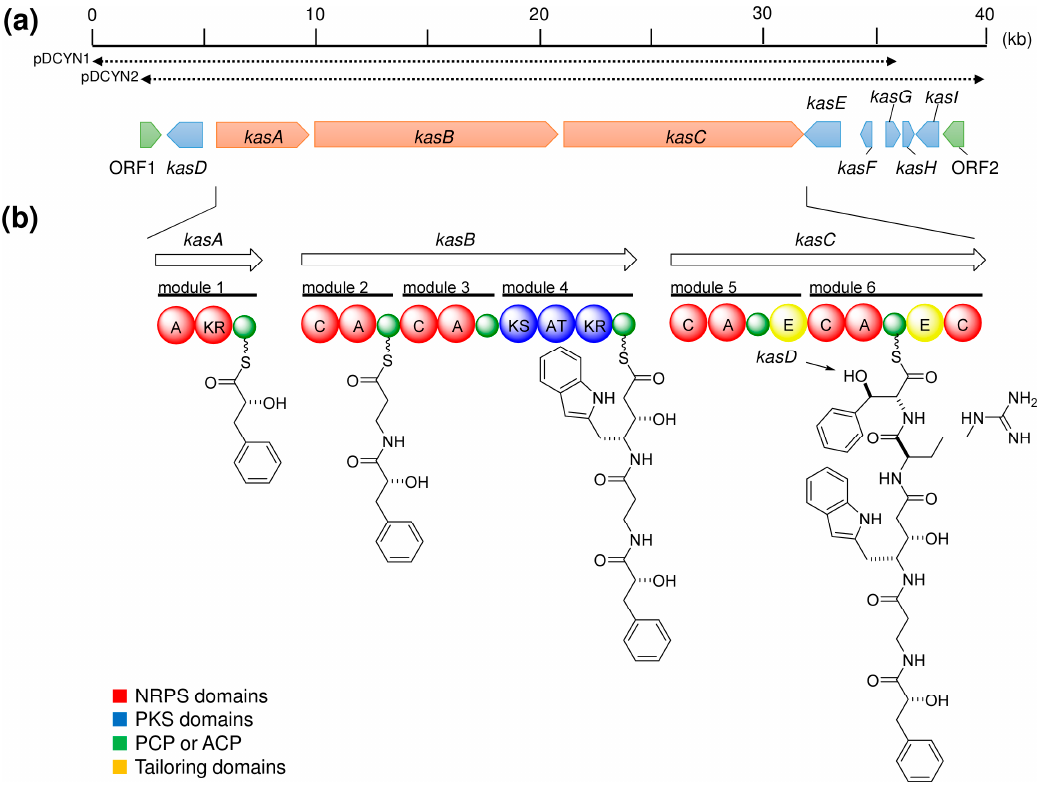
Figure 2. The biosynthetic gene cluster and proposed biosynthetic pathway to kasumigamide investigated by Nakashima, Egami, Kimura, Wakimoto, and Abe [162]. ( a ) ORFs encoded in the putative kasumigamide biosynthetic gene cluster, kasA-I . Double-headed arrows show the location of pDCYN1-2. The ORFs related to PKS-NRPS are highlighted in red. Putative transposases are coloured in green. ( b ) The domain organization and proposed biosynthetic pathway to kasumigamide [162].